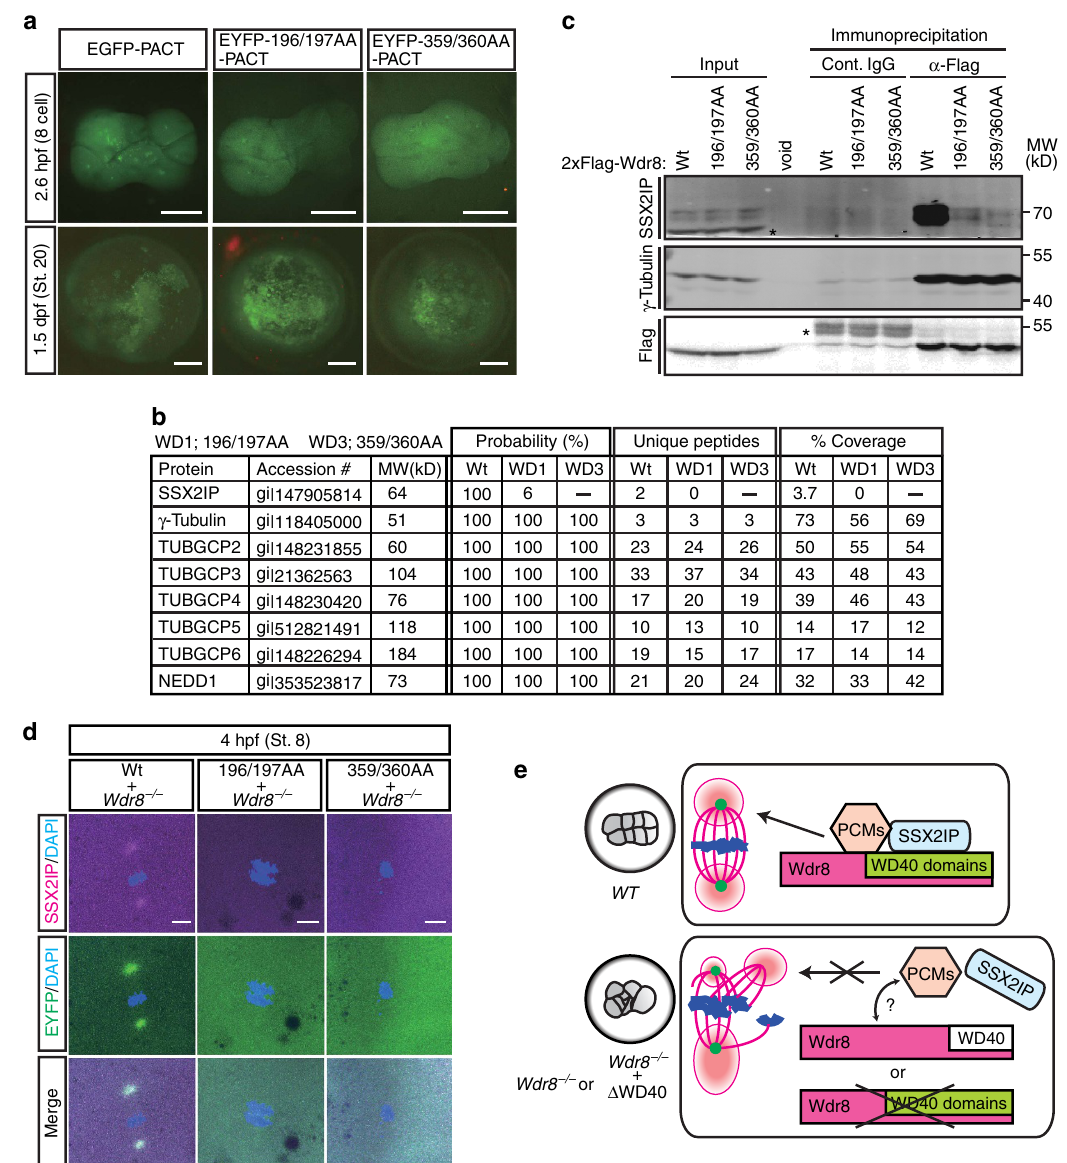
Figure 5 | WD40 domains is essential to form Wdr8–SSX2IP complex and its localisation. ( a ) The PACT domain could target EGFP to localise to the centrosome (positive controls) and mediated centrosome targeting of either EYFP-196/197AA-PACT or EYFP-359/360AA-PACT. However, this was insufficient for rescue of Wdr8 (cid:2) / (cid:2) embryos. ( b , c ) Identification of Wdr8 interaction factors by mass spectrometry and immunoblot analyses with Xenopus egg extracts. Wt, but not WD mutant variants, interacted with SSX2IP ( b , c ). By contrast, g -TuRC subunits/Nedd1 ( b ) and g -tubulin ( c ) interacted with Wdr8 independently of WD40 domains. *Background. ( d ) Interdependent localisation of Wdr8 and SSX2IP via WD40 domains. Due to failure of Wdr8– SSX2IP interaction, WD mutant variants, in contrast to Wt, were unable to colocalise with SSX2IP at the centrosome in Wdr8 (cid:2) / (cid:2) blastomeres. ( e ) Wdr8– SSX2IP localises to the centrosome to tether other PCM components (for example, g -TuRC, which is essential for maternal PCM assembly). The absence of maternal Wdr8 or dysfunction of its WD40 domains causes PCM assembly defects. Scale bars, 200 m m ( a ), 20 m m ( d ). Stages are denoted as hours per days post fertilisation (hpf, dpf) and the corresponding stage of WT are denoted in